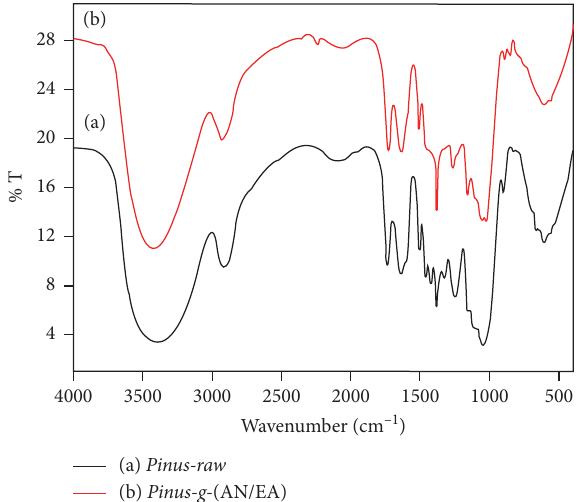
Figure 1: FTIR spectrum of (a) pinus-raw and (b)